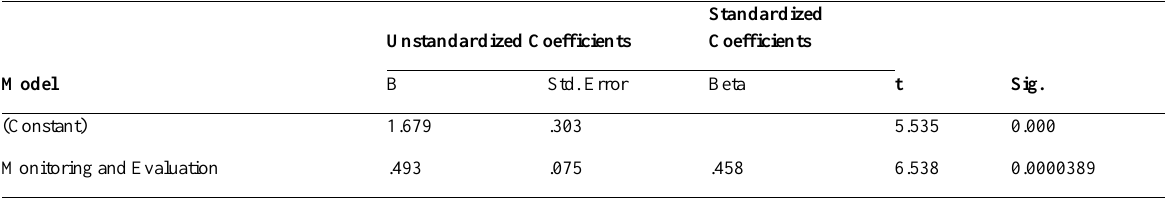
Table 8: Mathematical model for Monitoring and evaluation and sustainability of donor funded livelihood